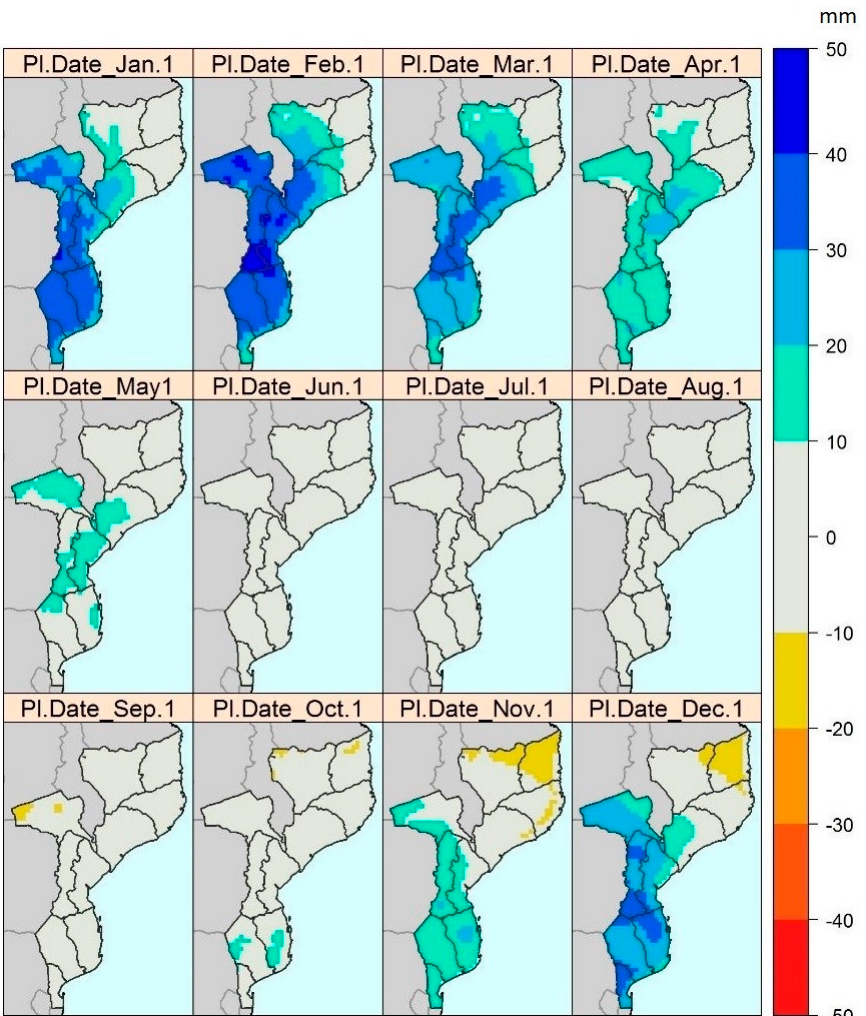
Figure 5. Spatial and temporal of deviation for El Niño of tomato crop total water requirement (mm) for Mozambique for a generic variety with 90-day growing cycle planted in the first day of each month.